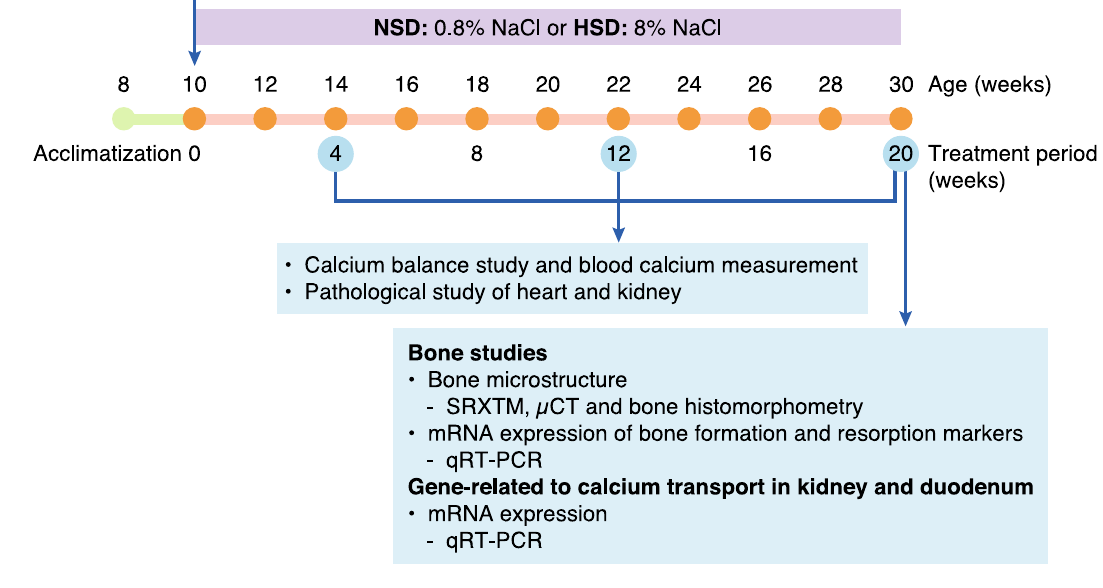
Figure 1. Timelines of the present